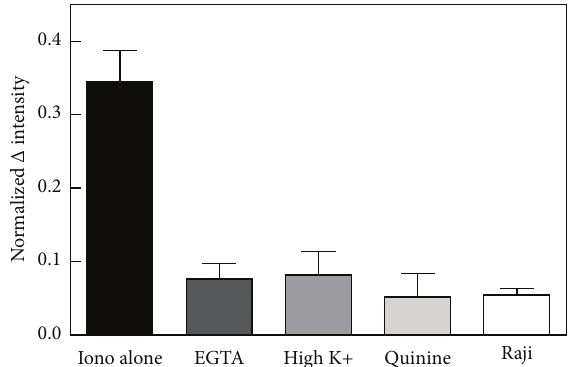
Figure 2: Ionomycin-stimulated microparticle release assayed by light scatter at 37 ∘ C. Ionomycin was added at the dotted line. An increase in scatter intensity indicates particle release [30].